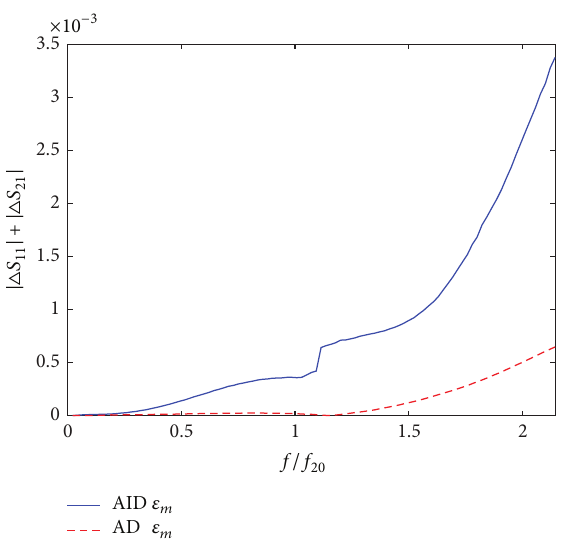
Figure 15: The 𝑆 -parameter differences at 𝜃 0 = 30 ∘ for two ABL- models. Solid curve: the case with angle-independent (AID) 𝜀 𝑚 (= (𝜃 = 0) of IBL-model); dashed curve: with angle-dependent 𝜀 𝑚 0 (AD) 𝜀 𝑚 .